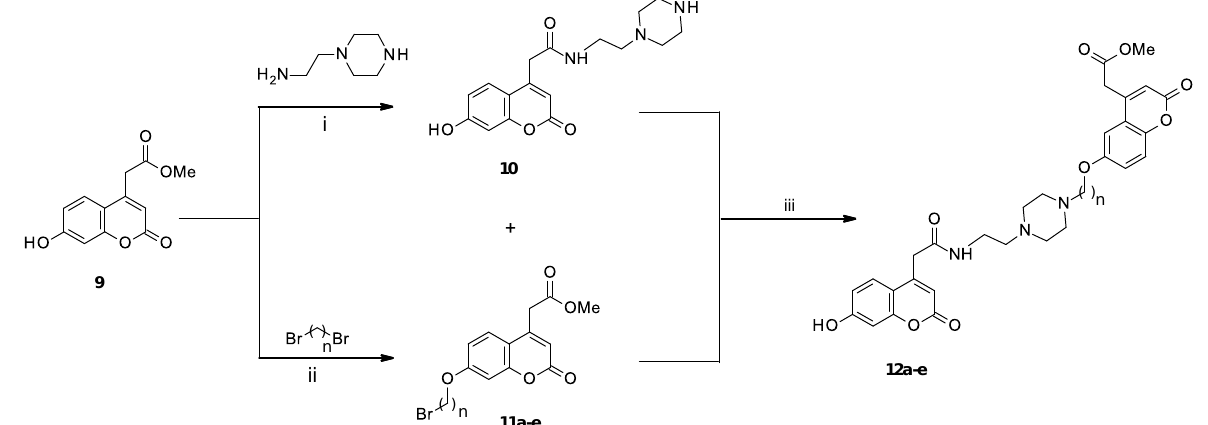
Figure 3. Synthesis of target biscoumarin derivatives 12a – e . Reagents and conditions: (i) CH 3 CN, reflux, 20 h, 94%, (ii) n = 3, 4, 6–8, K 2 CO 3 , dry acetone, reflux, 4 h, 38–73%, (iii) K 2 CO 3 , KI, dry acetone, reflux, 27–33 h, 30–68%.